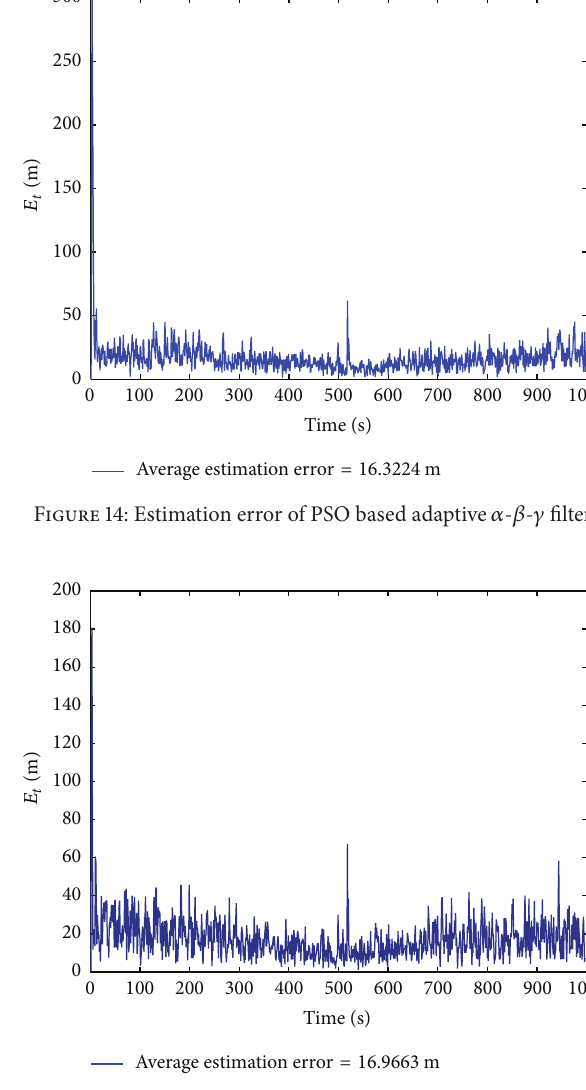
Figure 15: Estimation error of 𝛼 - 𝛽 - 𝛾 filter with 𝑔 𝑟,1 = 𝑔 𝑝,1 = 𝑔 2 = 0.1